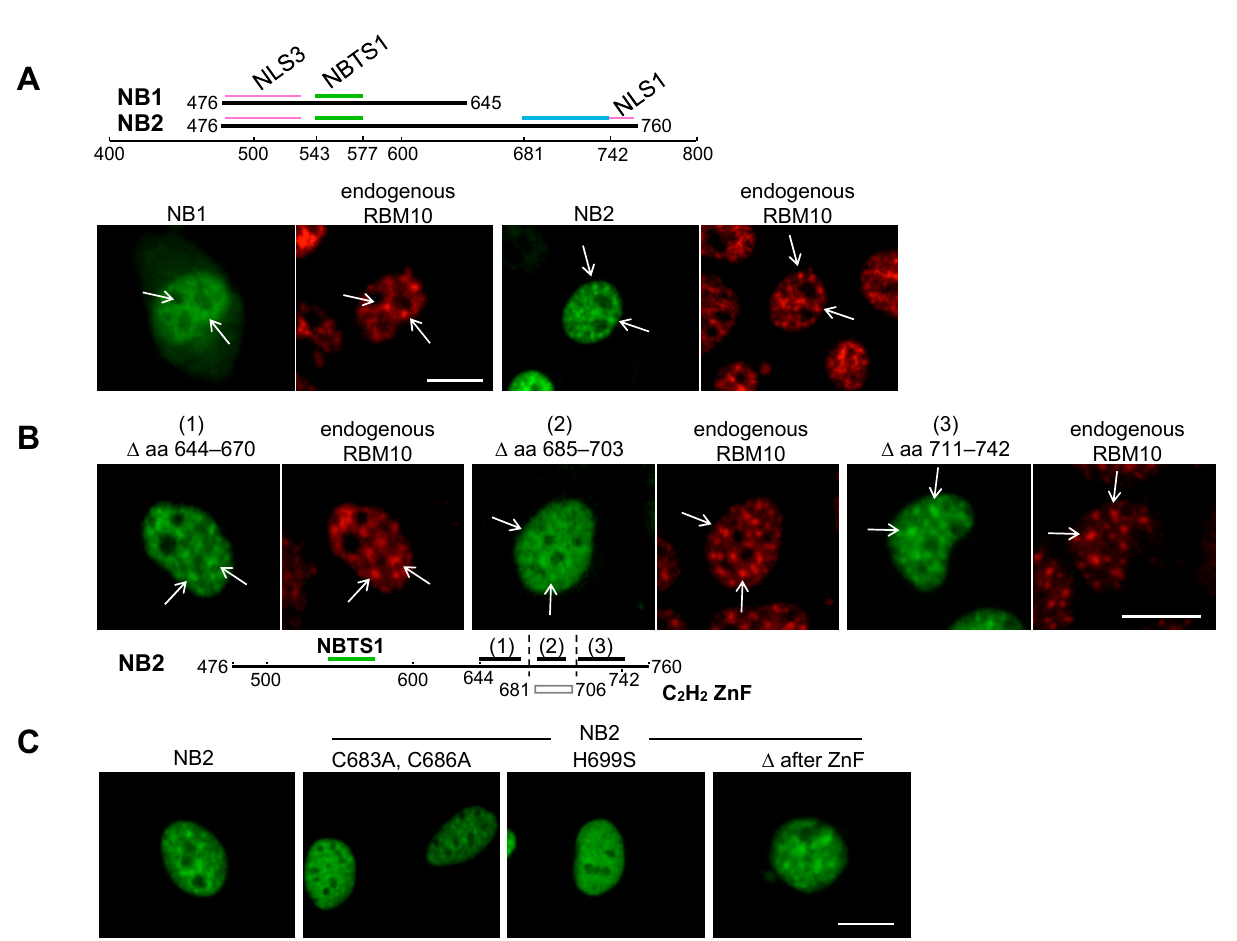
Figure 4. Identification of NBTS2. ( A ) NB1 and NB2. RBM10 sequences encoding aa 476–645 (NB1) and 476–760 (NB2) were ligated into pEGFP-C3 and expressed in ARL cells. Green bars in the upper panel represent NBTS1 in aa 543–577 (the KEKE region). The blue bar represents the region expected to contain an additional NBTS in aa 681–742. Purple bars indicate NLS3 (aa 482–540) and NLS1 (aa 743–759, the principal NLS [15]). Lower panels show expression of pNB1/EGFP-C3 and pNB2/EGFP-C3. Green, EGFP; red, endogenous RBM10 stained with anti-S1-1/RBM10 antiserum. Representative S1-1 NBs are indicated by arrows. ( B ). Determination of NBTS2. The region corresponding to aa 644–670 (control) (1), aa 685–703 (C 2 H 2 ZnF) (2), or aa 711–742 (after-ZnF) (3) was deleted from pNB2/EGFP-C3, and constructs were expressed in ARL cells. Green, EGFP; red, RBM10 stained with anti-S1-1/RBM10 antiserum. The lower diagram indicates the location of NBTS1 (green bar), deleted regions (1–3) (black bars), and the location of the C 2 H 2 ZnF (box, aa 681–706). ( C ) Confirmation of NBTS2. Two cysteines at 683 and 686 were substituted with alanine or histidine at 699 was substituted with serine in the C 2 H 2 ZnF of NB2/EGFP-C3. Green, EGFP. Scale bar: 10 µ